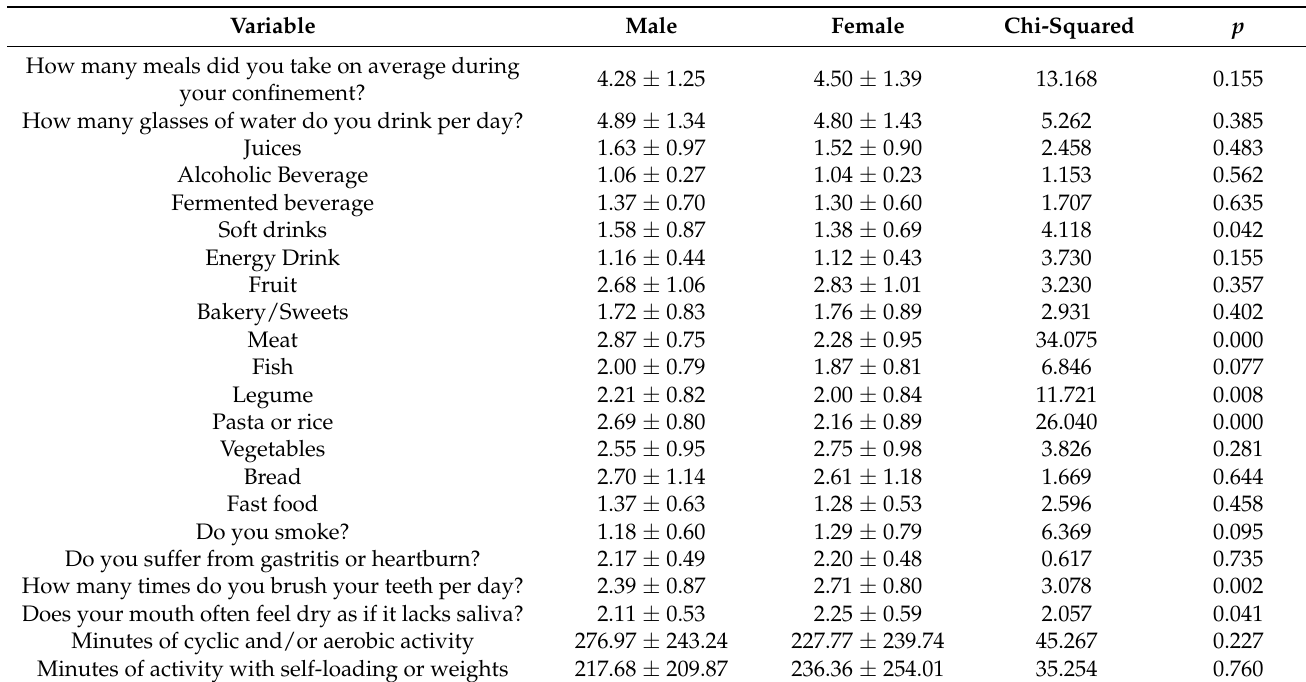
Table 4. Gender differences in the health-related